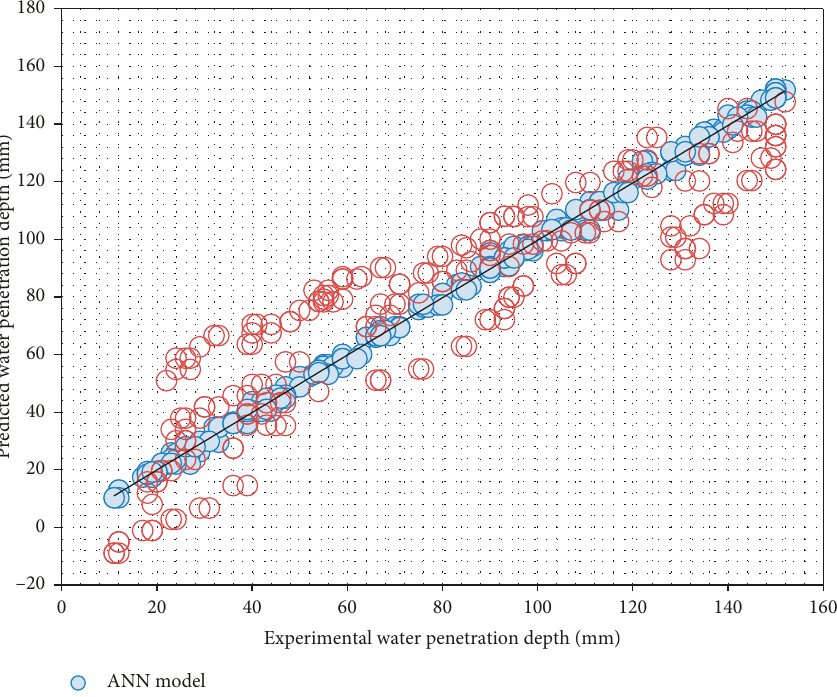
Figure 16: Predicted water permeability versus experimental water permeability for models ANN1 and